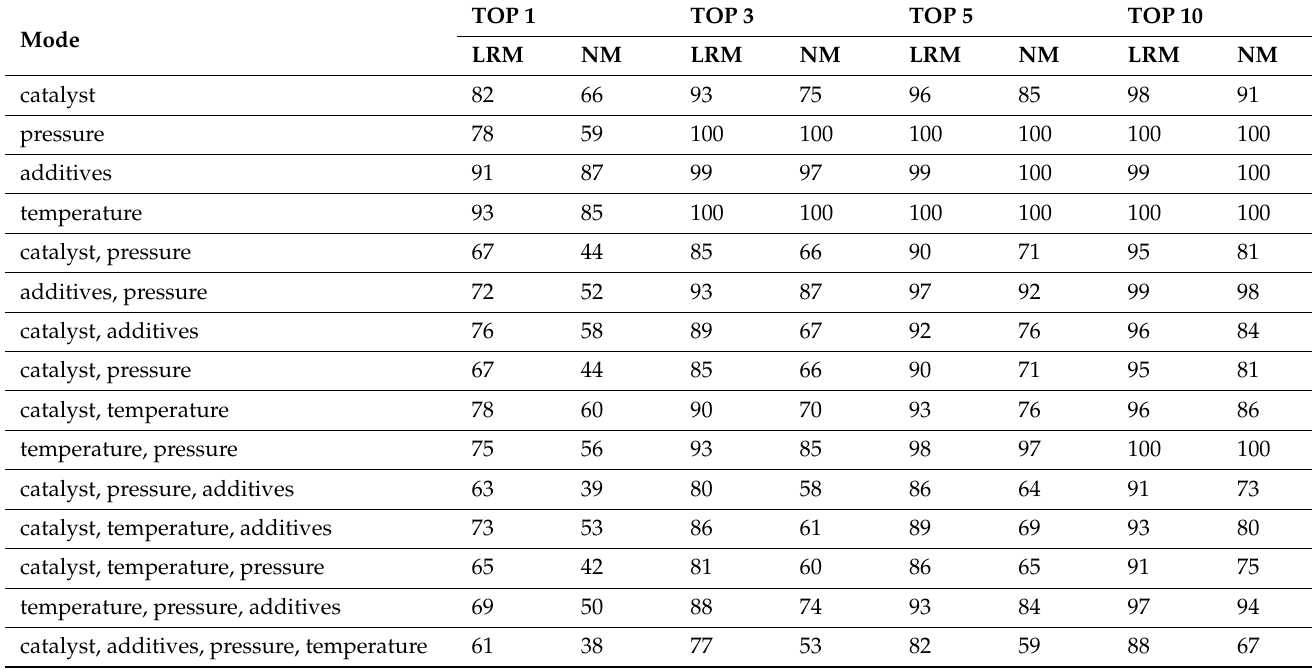
Table 1. Percentage of cases for which at least one of experimental condition component combinations were found within the top of a sorted list of predicted conditions (retrospective test set). LRM— likelihood ranking model, NM—null